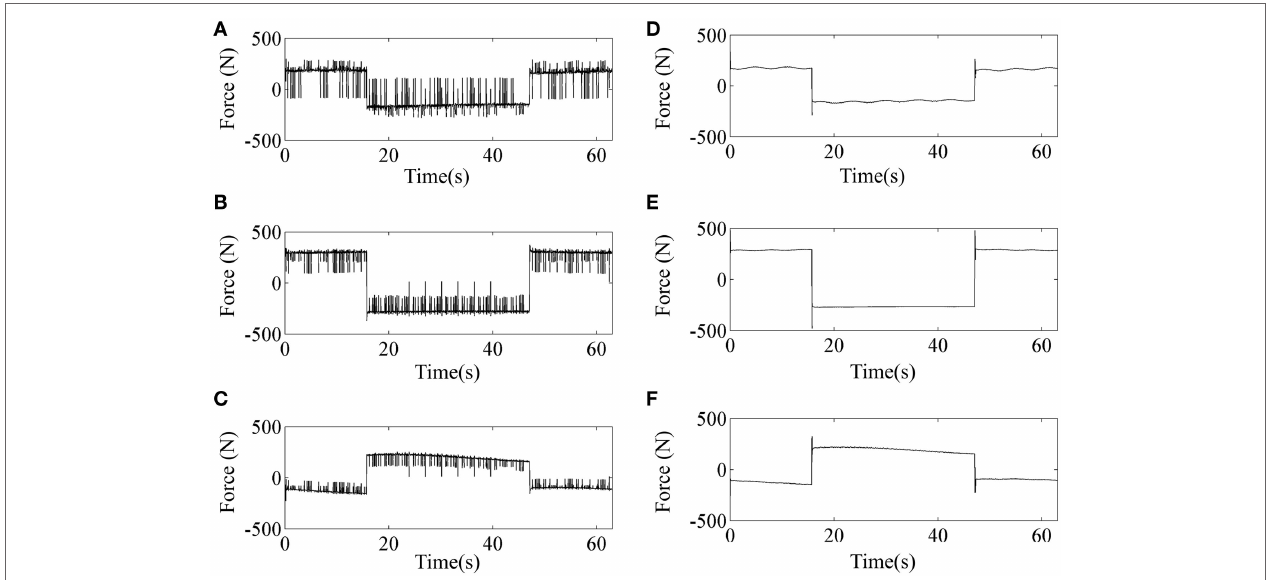
FIGURE 4 | The output forces for the three wires via sliding mode control (SMC) and sliding mode control with nonlinear disturbance observer (SMCNDO). (A) The output force for wire 1 via SMC, (B) the output force for wire 2 via SMC, (C) the output force for wire 3 via SMC, (D) the output force for wire 1 via SMCNDO, (E) the output force for wire 2 via SMCNDO, and (F) the output force for wire 3 via SMCNDO.